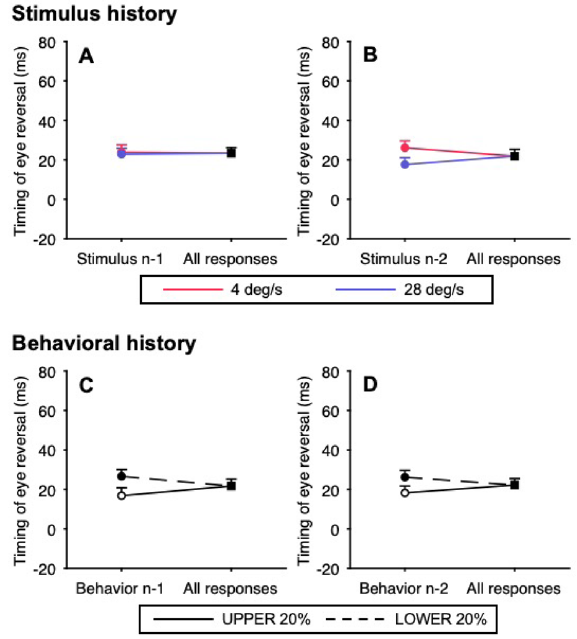
Figure 5. Effects of stimulus and behavioral histories on the timing of eye reversal in the unpredictable condition. For the stimulus history, trials were sorted based on whether the target velocity in the n-1 ( A ) or n-2 trial ( B ) was 4 deg/s (red) or 28 deg/s (blue). For the behavioral history, trials were sorted by the same classification as the predictable condition ( C : trials sorted by the n-1 trial; D : trials sorted by the n-2 trial). In the left node, the open symbol and solid line represent the trials preceded by a response from the UPPER trials, and the filled symbols and dushed lines represent the trials preceded by a response from the LOWER trials. Error bars indicate 1